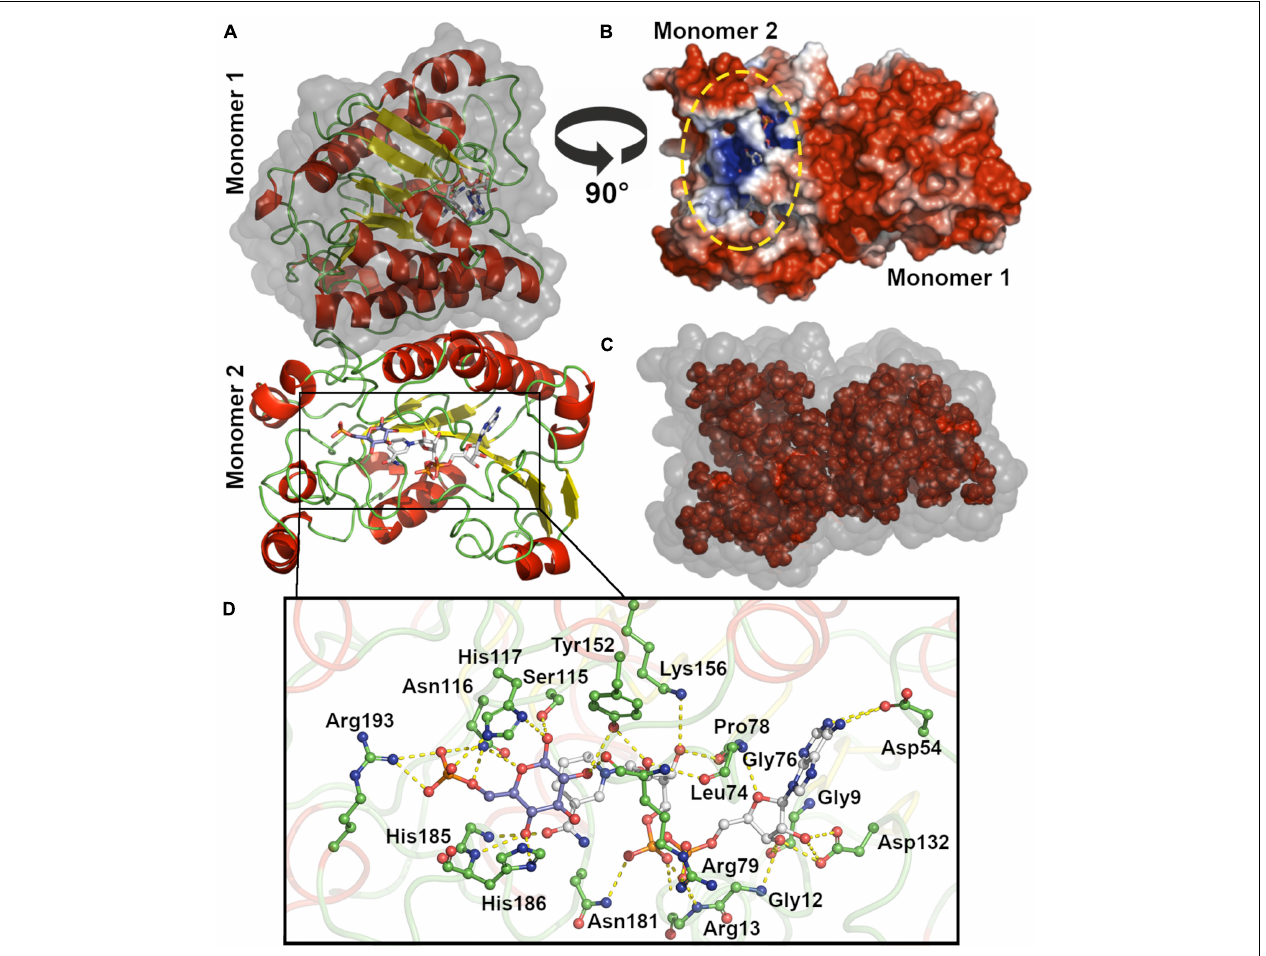
FIGURE 4 | Molecular modeling and active site of Hv G6PDH. (A) Dimeric Hv G6PDH architecture. Each monomer is represented as a cartoon: α helix (red), β -sheets (yellow), and loops (green). The surface of one of the monomers is shown in gray. (B) Surface electrostatic potential for the Hv G6PDH model, being blue for positive and red for negative potential ( ± 3 kB T/e). The structure is represented as the solvent-excluded surface (Connolly surface). The yellow oval denotes the active site. (C) Residues from the hydrophobic core (inner shell), using as criteria less than 20 Å 2 exposed. The structure is represented as the solvent accessible surface (SAS); the surface is represented in gray and the residues from the inner shell as red spheres. (D) Active site residues. The residues at 5 Å from G6P and NAD + ligands are shown, and those establishing polar interactions are represented as sticks and balls. The carbon atoms of the G6P molecule are shown in blue–purple, those of NAD + in white, and the carbon of the amino acid residues in green. The oxygen atoms are red and nitrogen